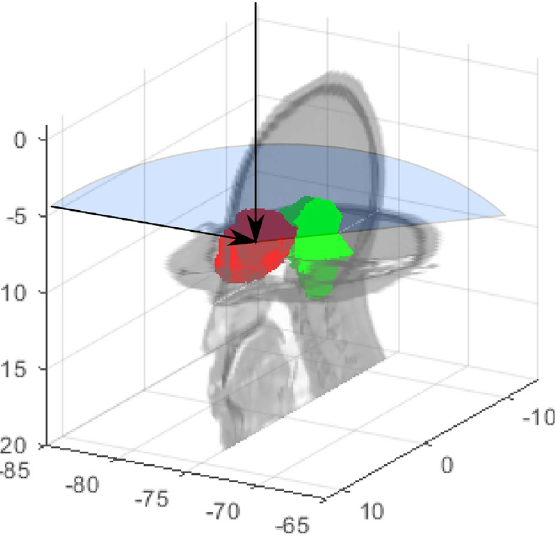
Figure 2. Treatment planning geometry of the patient, target (red), and brainstem OAR (green). Beam directions are shown for the multi-field IMPT treatments as represented by solid arrows and the partial arc bounded by the blue sector. Plot coordinates are in units of